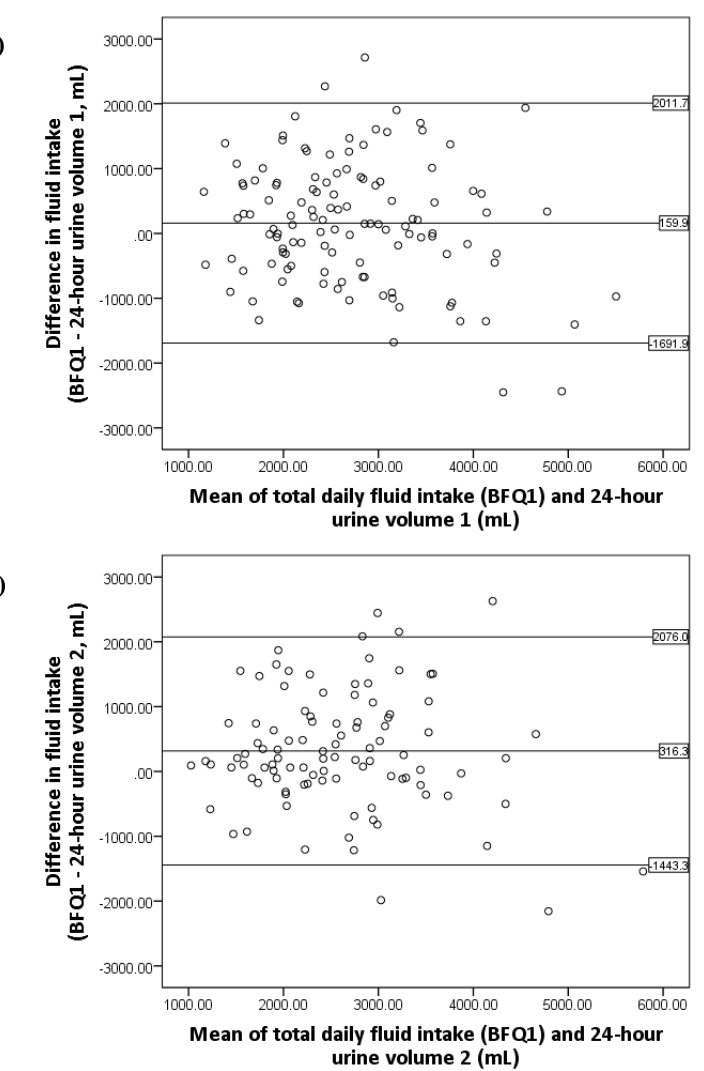
Figure 2. Bland–Altman plots of total daily fluid intake and ( a ) First 24-h urine volume, ( b ) Second 24-h urine volume, and ( c ) Mean 24-h urine volume with 95% limits of agreement. 3.3. Reliability of the